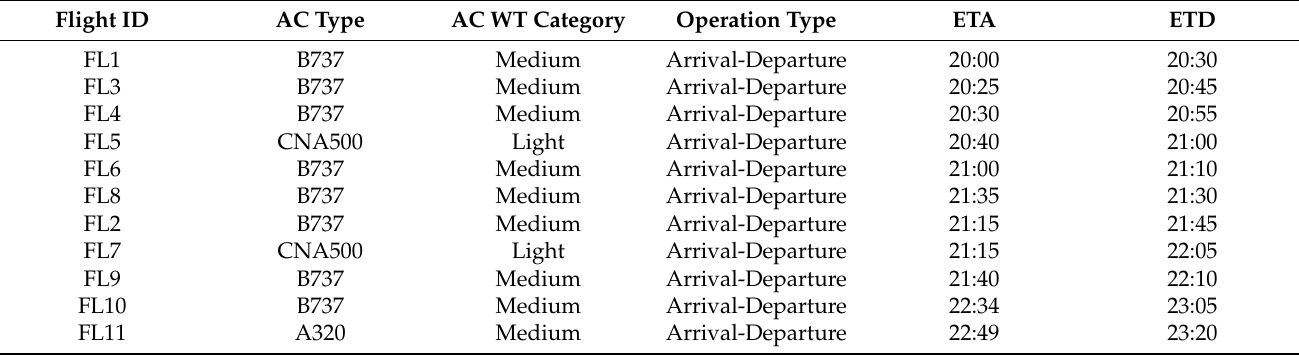
Table 3. Flights in the reference scenario